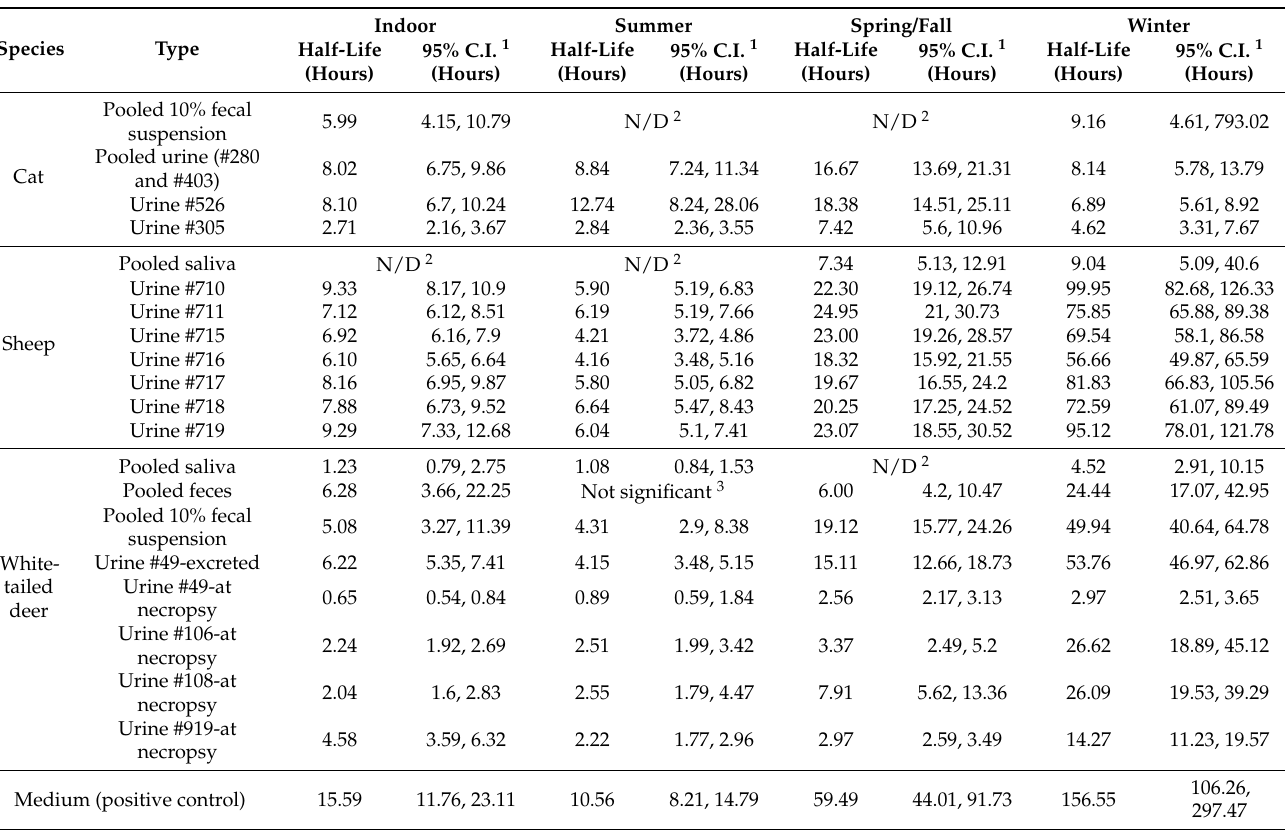
Table 2. The half-life values of SARS-CoV-2 in biological fluids from cat, sheep, and white-tailed deer under indoor and three different climatic conditions.